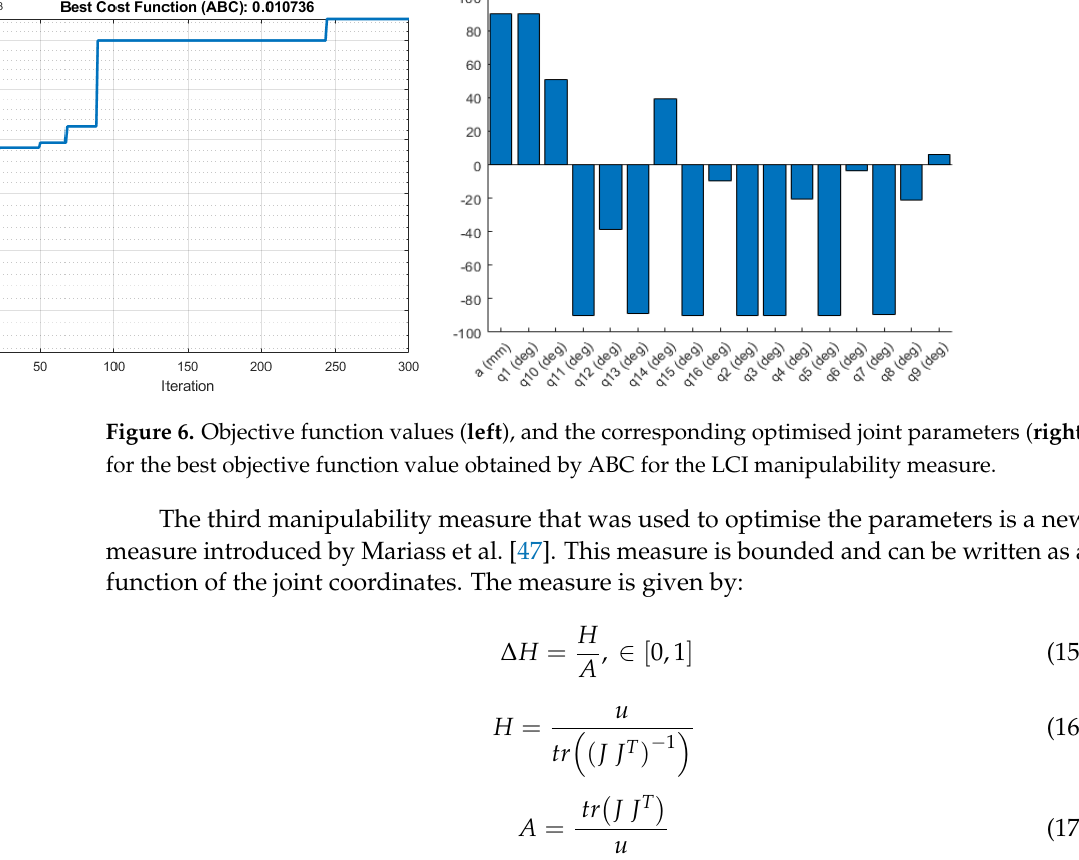
Figure 5. Objective function values ( left ), and the corresponding optimised joint parameters ( right ) for the best objective function value obtained by Fmincon for the LCI manipulability measure.